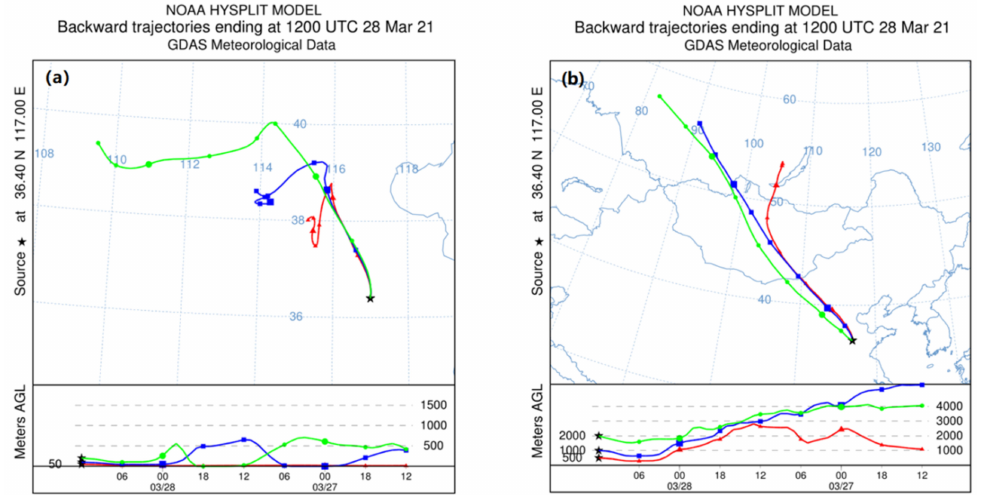
Figure 8. The 48 h backward trajectories: ( a ) low-altitude backward trajectory at 12:00 p.m. on 28 March; ( b ) high-altitude backward trajectory at 12:00 p.m. on 28